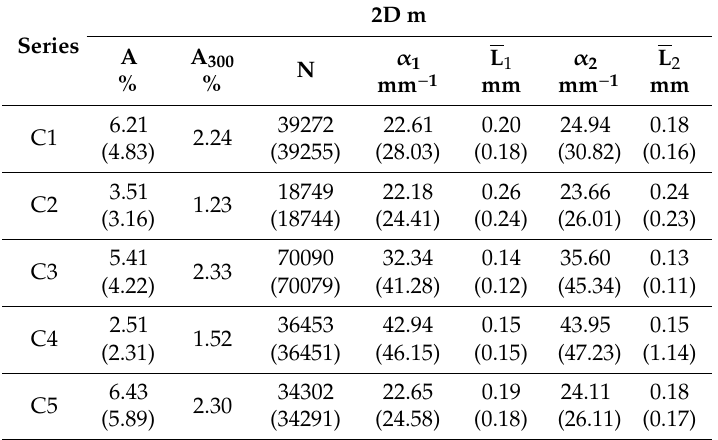
Table 5. Results of air void parameter assessment by 2D with manual separation of connected air voids.